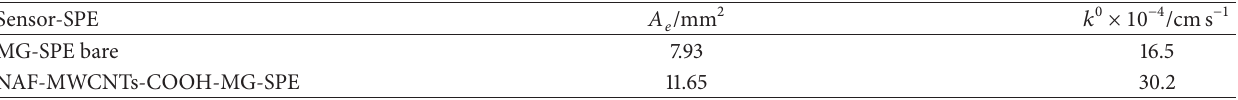
Table 4: Electroactive area and heterogeneous standard rate constant of bare screen-printed sensor and after the modification step. Sensor-SPE